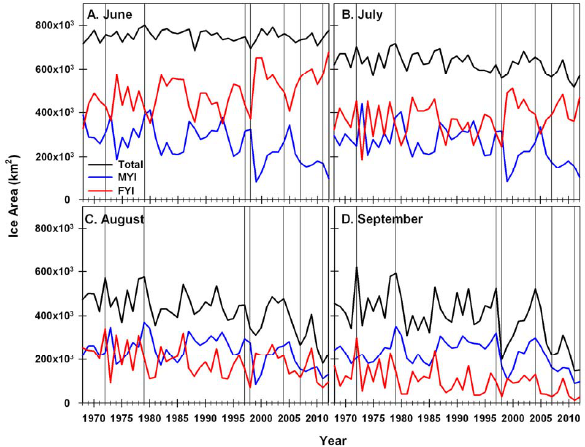
Figure 2. Time series of mean monthly total ice, multi-year ice (MYI) and first-year ice (FYI) area (km 2 ) within the Canadian Arctic Archipelago for June to September (A-D) from 1968- 2012. The vertical bars represent the extreme light and heavy years.